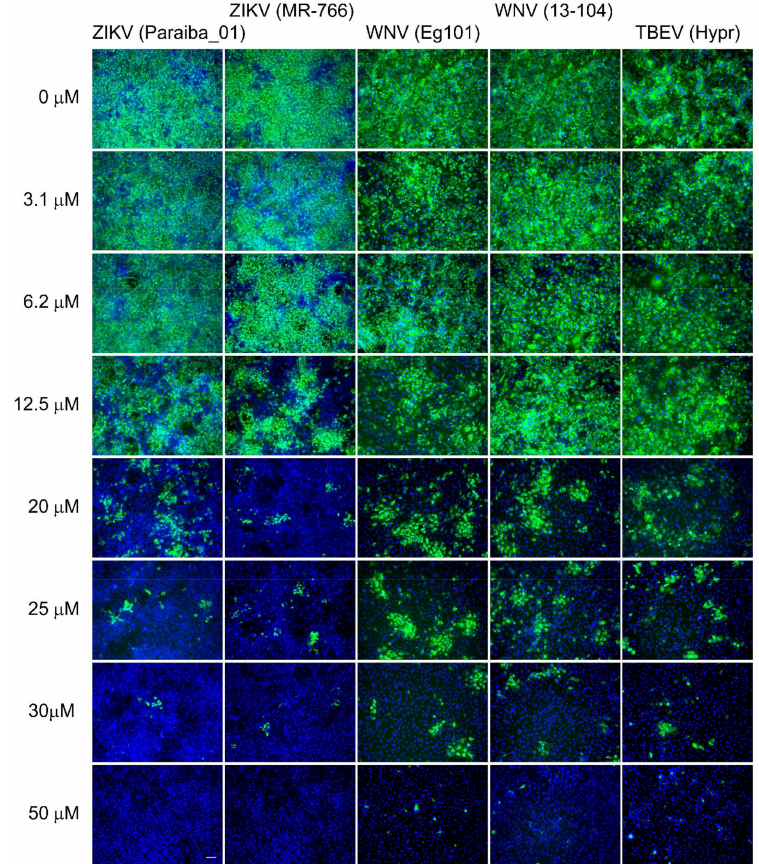
Figure 2. Inhibition of flaviviral surface E antigen expression by arbidol. Vero cells infected with virus were fixed on slides 48 h after infection and stained with flavivirus-specific antibody labeled with FITC (green) and counterstained with DAPI (blue). Scale bar, 50 µ